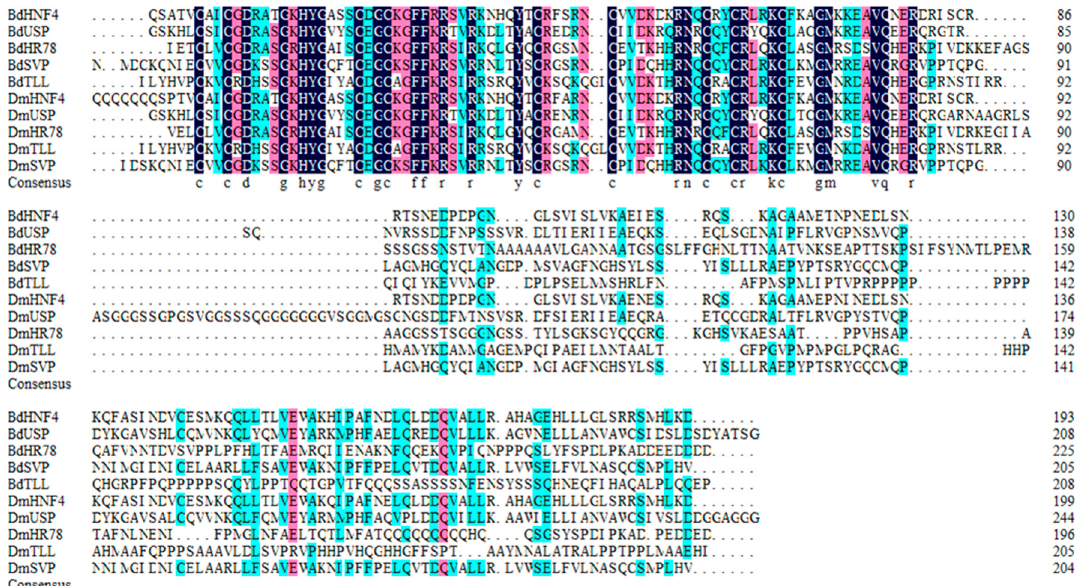
Figure 7. Conserved regions in the NR1 subfamily of B. dorsalis and D. melanogaster NR proteins. Amino acid sequences of the catalytic domains of the NR1 subfamily were aligned using DNAMAN 6 (https://www.lynnon.com/downloads.html). Identical and highly conserved amino acids are indicated by black (100%), pink (75%), and blue (50%), respectively.